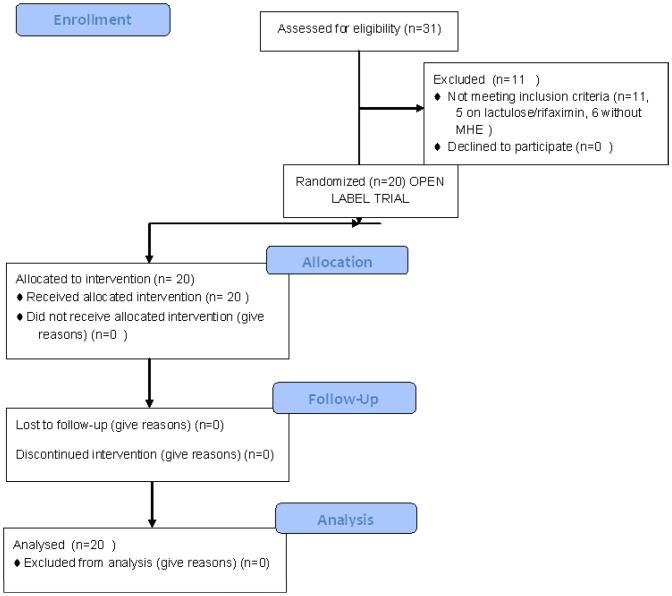
Consort Flowchart of the Open-label trial.